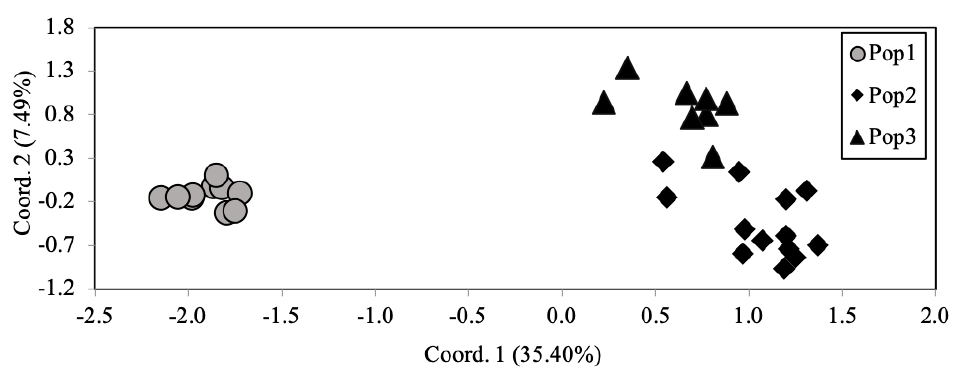
Figure 1. Principal Coordinates Analysis Plot of Pop1 (grey circle), Pop2 (black diamond), and Pop3 (black triangle) based on codominant genotypic distances. Axis 1 explains 35.4% of the variance and axis 2 explains 7.49% of the